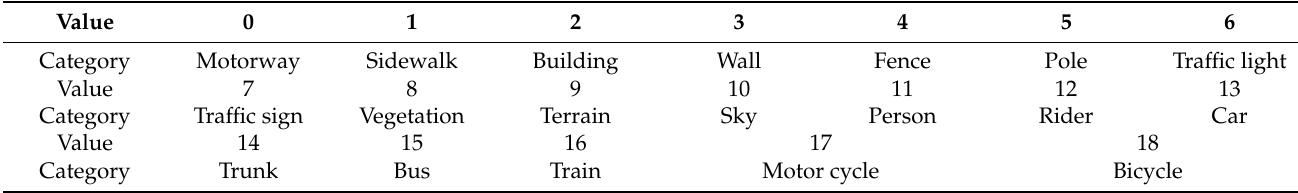
Table 2. The pixel values and corresponding categories in annotated images of the Cityscape data.